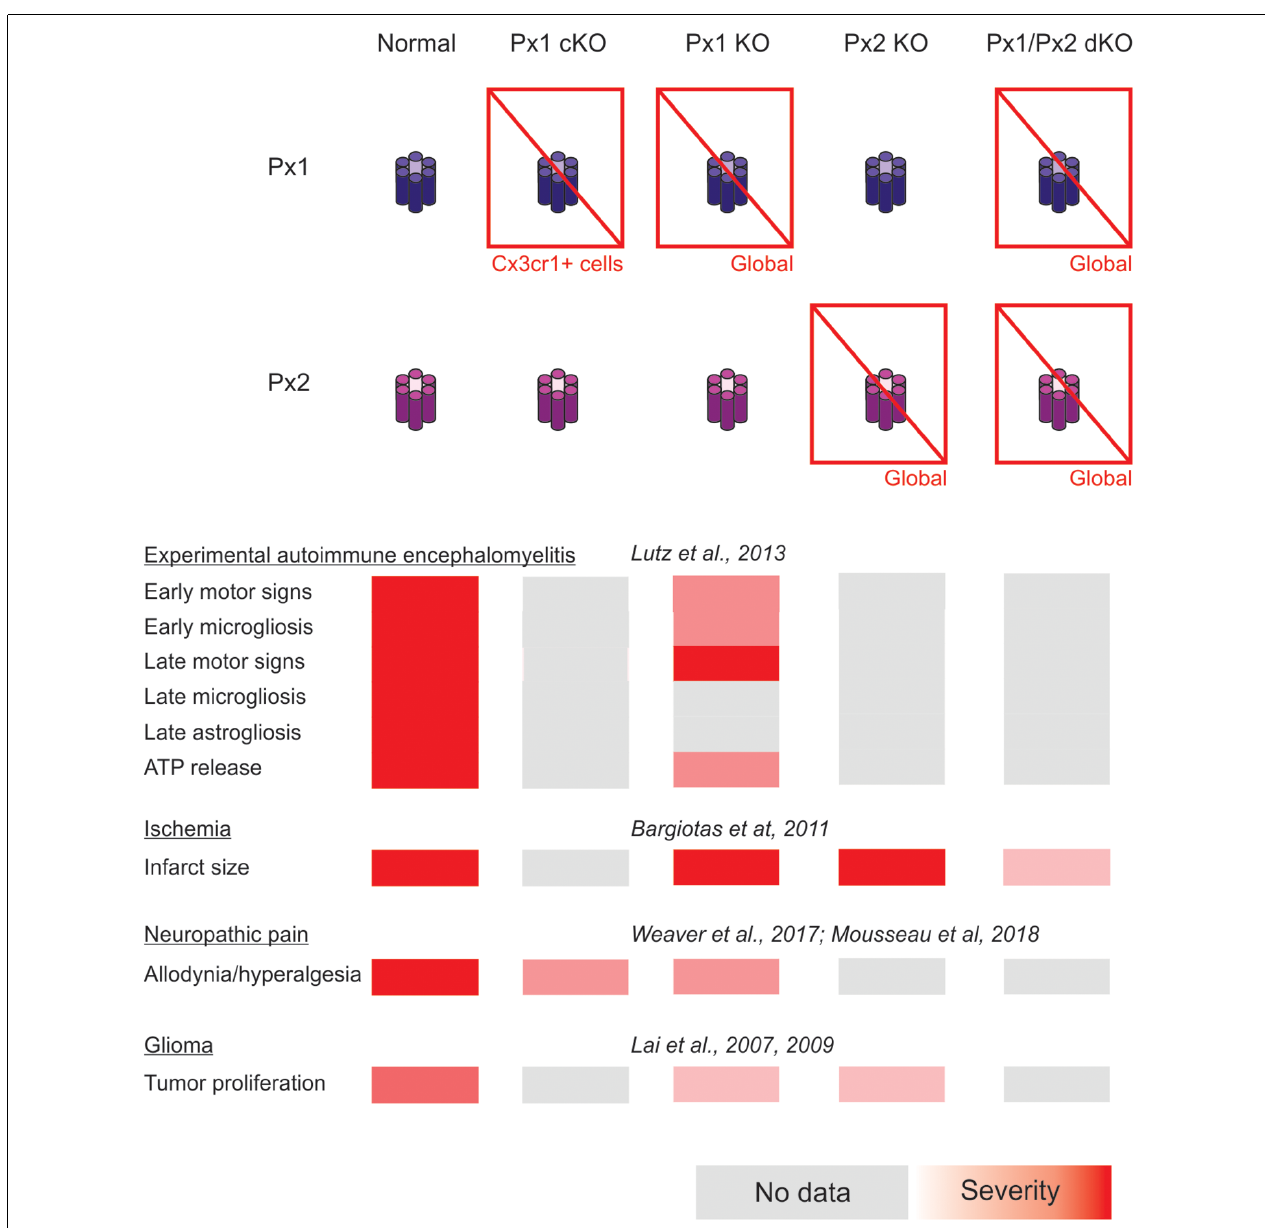
FIGURE 2 | Summary of the impact of global and myeloid cell-selective pannexin function disruption in the context of in vivo models of central nervous system disease.